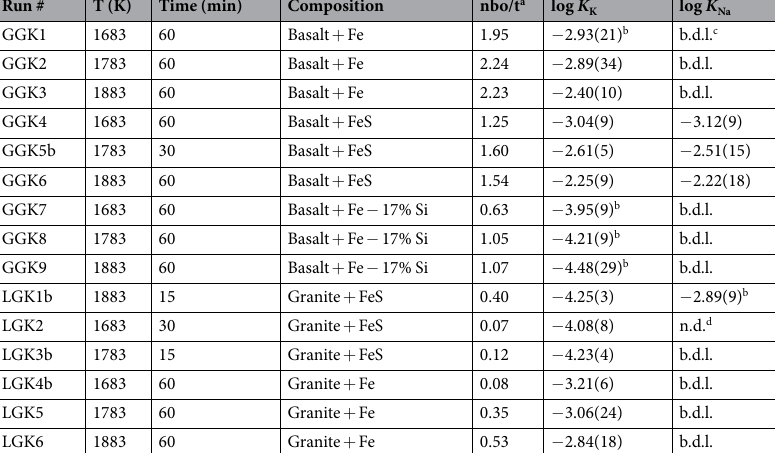
Table 1. Experimental run conditions and measured equilibrium constants for K and Na at 1 GPa. All values are based on LA-ICP-MS measurements of both metal and silicate, except for run GGK6 (Supplementary Information). Numbers in brackets are errors in terms of least digits cited and calculated through simple error propagation while assuming 2 standard errors for EPMA and LA-ICP-MS analyses. a nbo/t = [2 × O − 4 × T]/T where [2 × O − 4 T] refers to the number of non-bridging oxygen ions and T represents the number of tetrahedrally coordinated cations 28 b Close to or below detection limit c Below detection limit d Not